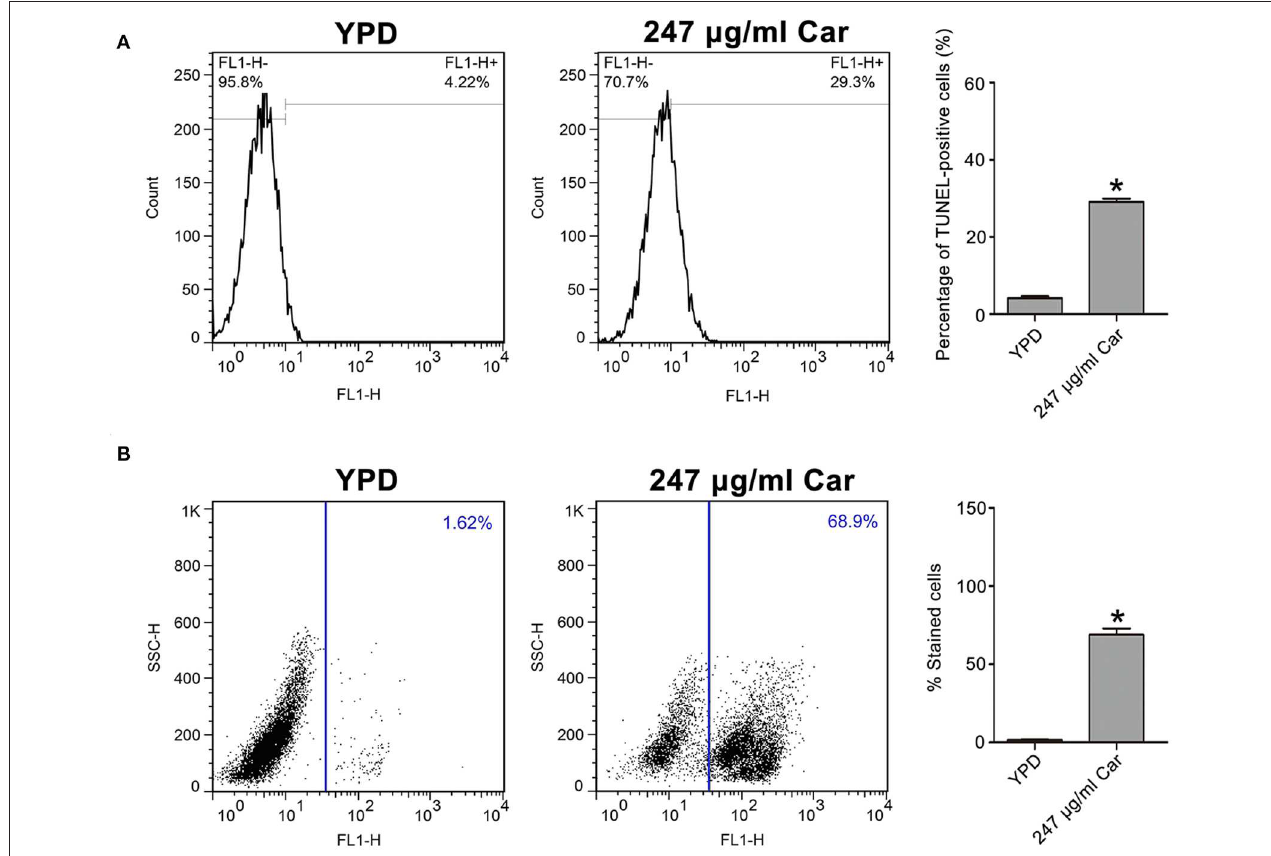
FIGURE 3 | DNA fragmentation and metacaspase activation were analyzed in carvacrol-treated C. albicans cells. (A) DNA fragmentation was determined using TUNEL staining. The histogram was the quantitative analysis of TUNEL-positive cells, and data were presented as mean ± SD ( n = 3). * P < 0.05. (B) Metacaspase activation was assessed using CaspACE FITC-VAD-FMK in situ marker. The percentage of stained cells was shown in the histogram, and data were expressed as mean ± SD ( n = 3). * P < 0.05.